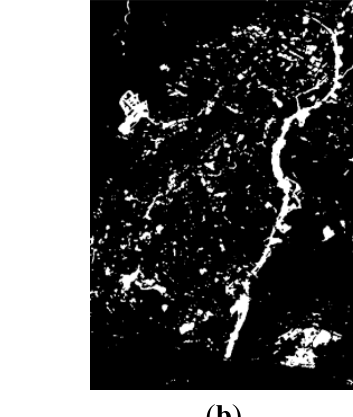
= 0.6, λ = 0.4) ( a ) Summative CVA NDVI